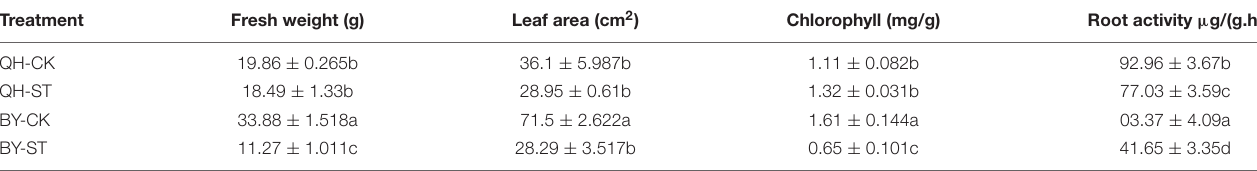
FIGURE 2 | Heat map clustering and two-factor principal component analysis of all indicators in seedling stage. (A) Heat map clustering of all indicators in seedling stage. (B) Two-factor principal component analysis of all indicators in seedling stage. “CK,” “T,” and “C” are markers for different calculation methods, “CK” are measurement indicators of Chinese cabbage seedlings treated with 0 mol L - 1 NaCl, “T” are indicators of Chinese cabbage seedlings treated with 100 mol L - 1 NaCl, “C” is the relative value (the value of 100 mol L - 1 /0 mol L - 1 NaCl treatment), and index is the salt injury index (%) of Chinese cabbage seedlings treated with NaCl stress. TABLE 1 | Effect of salt on the growth parameters of Qinghua45 (QH) and Biyuchunhua (BY).